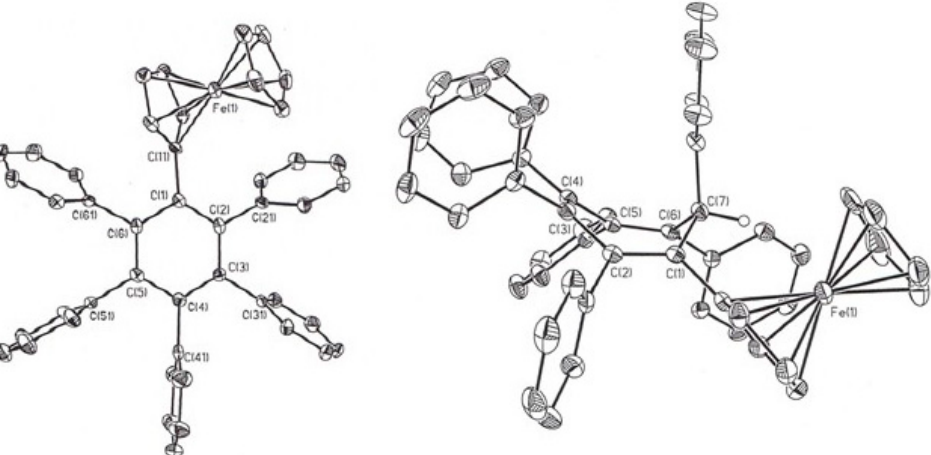
Figure 11. Molecular structures of ( left ) ferrocenylpentaphenylbenzene, 23 , and ( right ) ferrocenylhexaphenylcycloheptatriene, 24 . Figure 11 is reprinted with permission of the American Chemical Society.